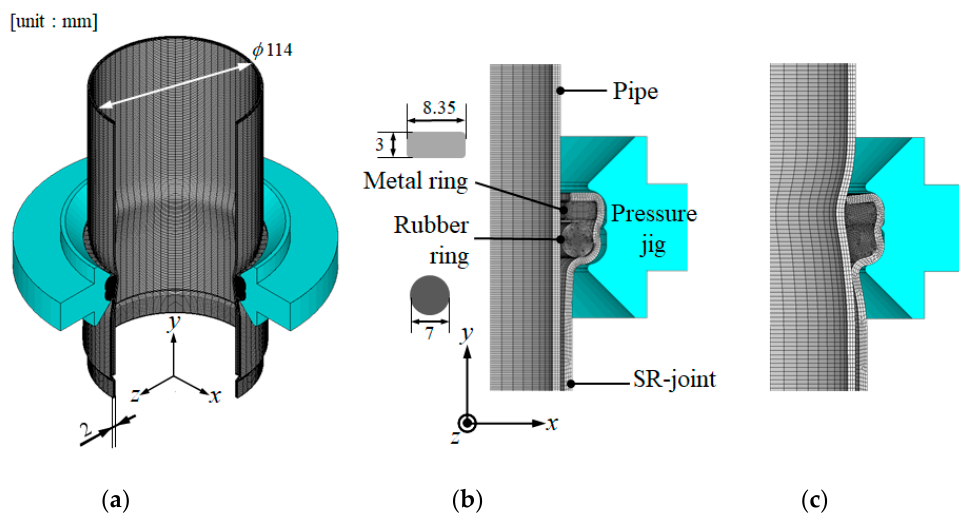
Figure 4. Geometry and FE modeling of a conventional stainless ring (SR)-joint (SR-I). ( a ) overall mesh design ( b ) detailed dimensions for each part ( c ) deformed shape of each part after compression.